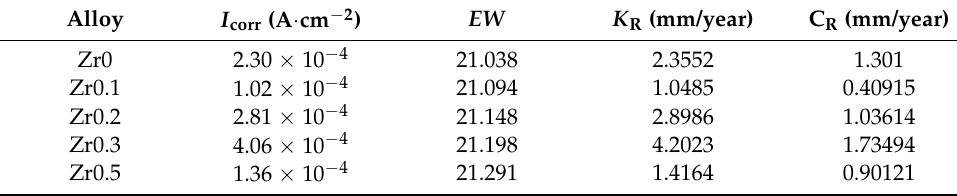
Table 5. The corrosion rates obtained from the polarization measurements and immersion tests.